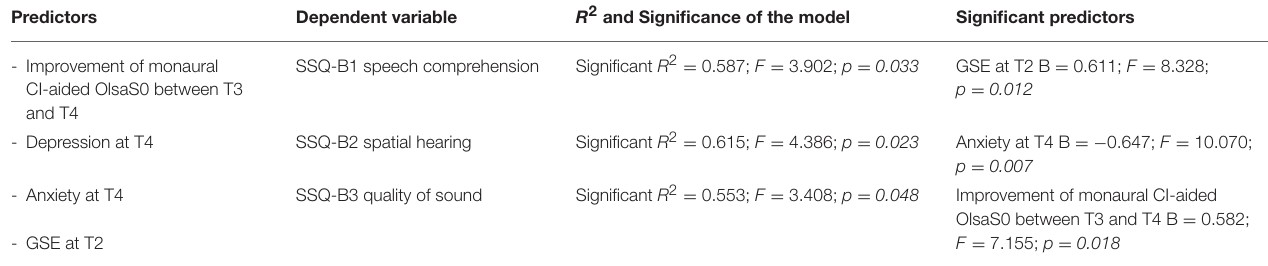
TABLE 3 | Results of regression